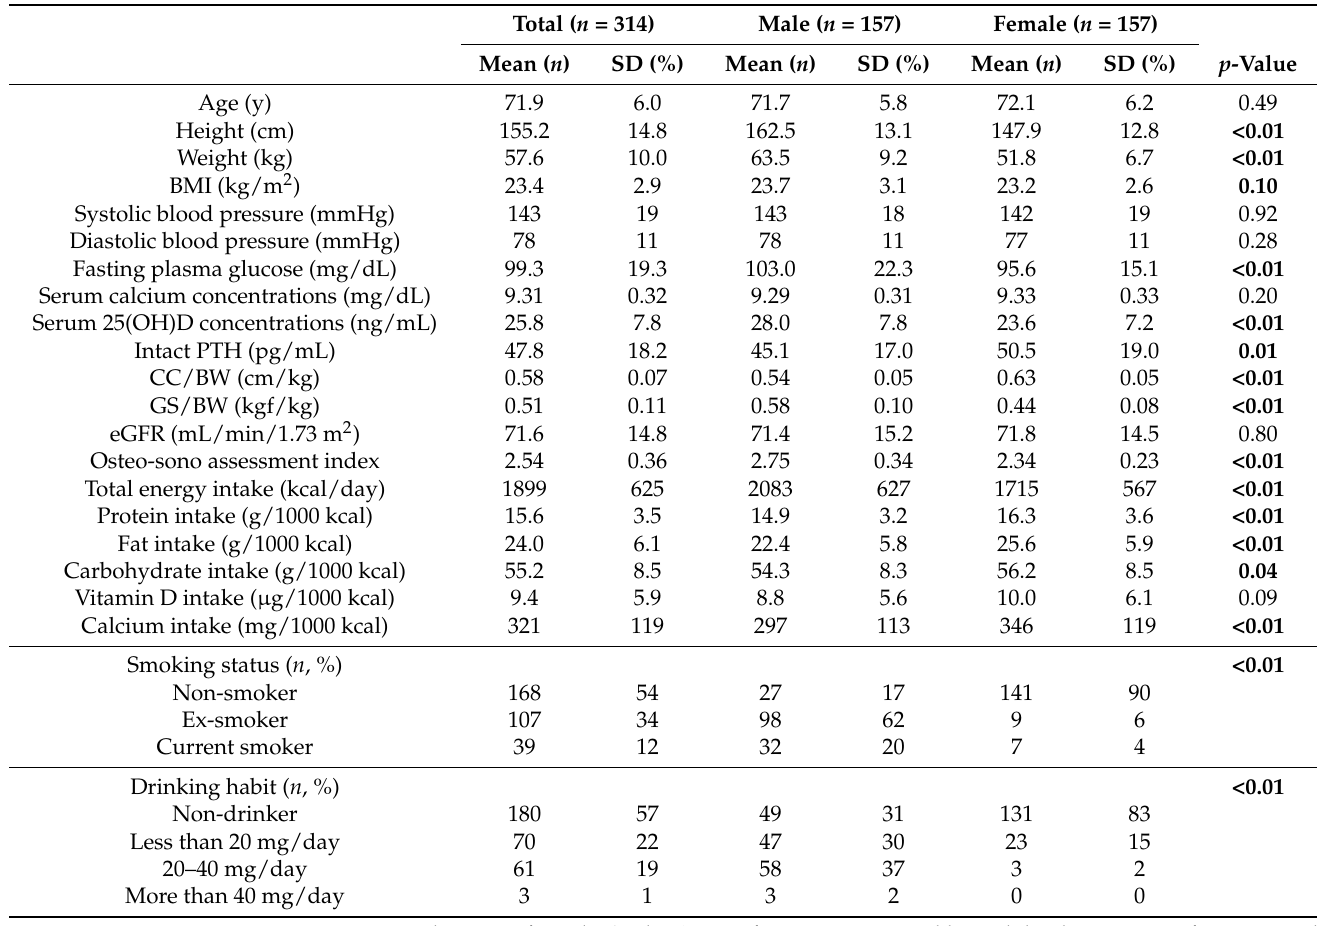
Table 1. Participant